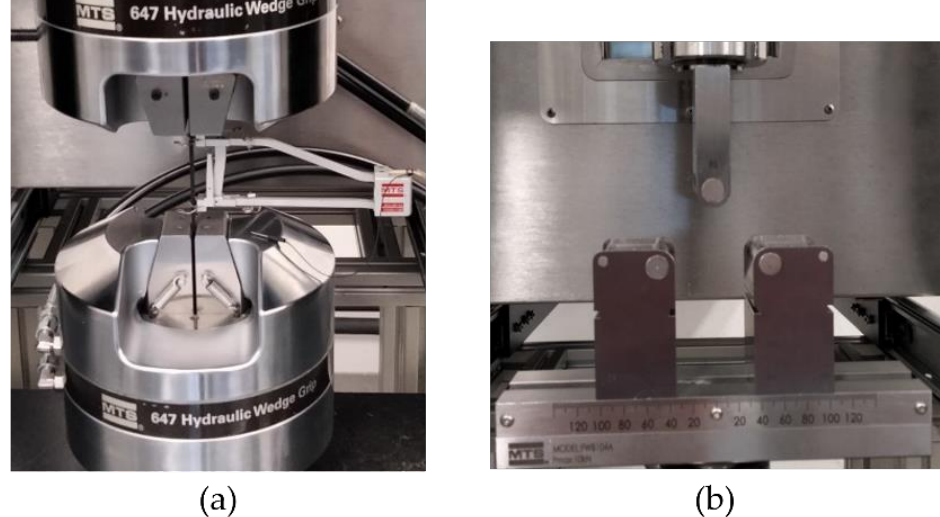
Figure 4. MTS Insight machine fixtures for ( a ) tensile and ( b ) bending tests at room temperature.